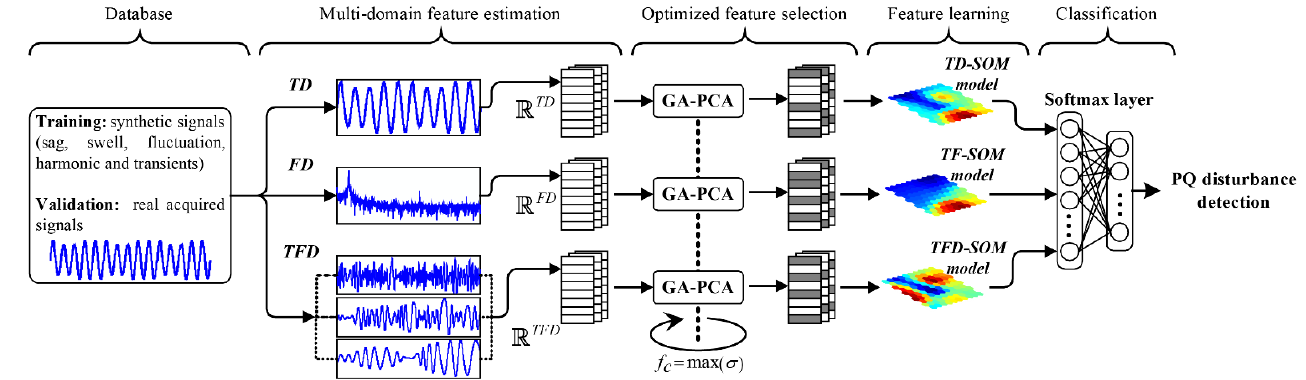
Figure 3. Diagram of the proposed methodology based on an optimized multi-domain feature selection for the detection and classification of disturbances.